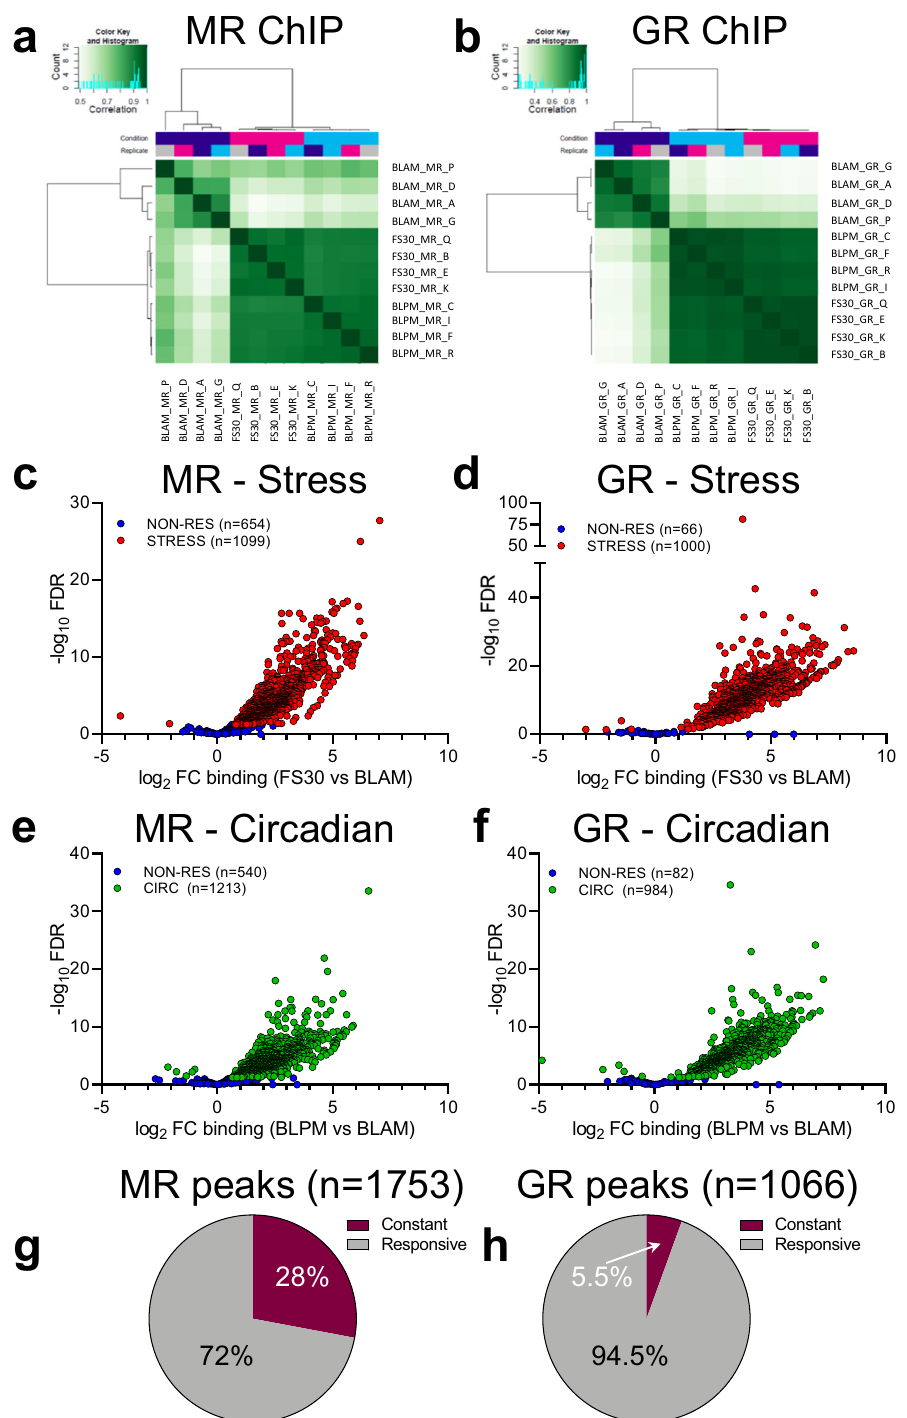
Fig. 2 Differential binding of MR and GR after acute stress or during the circadian rise as compared with early morning baseline (BLAM) conditions. Differential binding (DiffBind) analysis determined whether the binding of MRs and GRs was signi fi cantly up- or down-regulated following acute stress (FS30) or circadian changes (BLPM) compared with BLAM conditions. a , b Correlation heat maps represent read count data of biological replicates subjected to DiffBind analysis ( a MR ChIP; b GR ChIP). c – f Scatterplots display the fold-change in binding (log 2 FC) of MR and GR versus the statistical signi fi cance of the change (-log 10 FDR) following acute stress (FS30 vs BLAM: c MR; d GR) or during circadian changes (BLPM vs BLAM: e MR; f GR). Stress-responsive (STRESS) and circadian-responsive (CIRC) peaks are shown as red circles and green circles, respectively. Blue circles depict nonresponsive (NON-RES) peaks. The number of peaks are given between brackets. Pie charts showing the proportion of MR peaks ( g ) and GR peaks ( h ) signi fi cantly responding to either stress or circadian in fl uences (Responsive), or peaks in which receptor binding remained unchanged to both conditions (Constant). Source data are provided in the Source Data